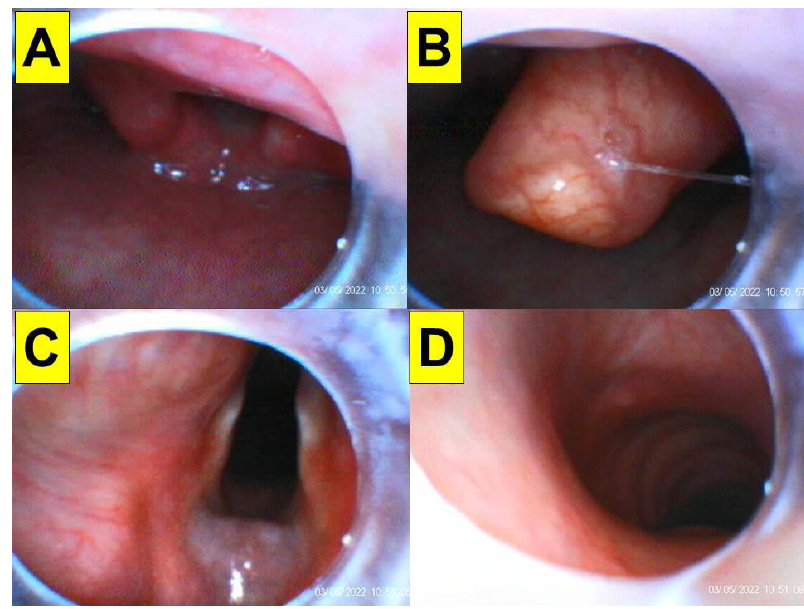
Figure 8. An omega-shaped epiglottis facilitates the intubating stylet technique. ( A ) Quick approach to the glottis region from the left side of the epiglottis, ( B ) view of the omega-shaped epiglottis, ( C ) full glottic visualization, ( D ) entry into the trachea. The patient was a 73-year-old man (154 cm, 65 kg, BMI 27.4 kg/m 2 , neck circumference 35 cm) who received orthopedic surgery (also see the Supplementary Materials, Video S5). It took 20 s (from the lip to the trachea) to complete the intubating process.